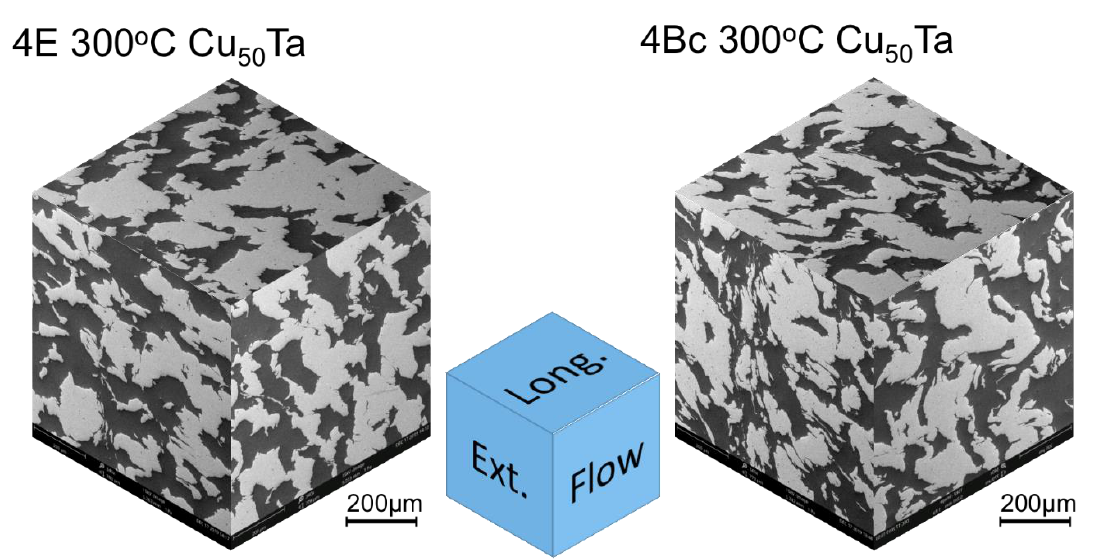
Figure 4. 3-D representation of microstructure along three different sectioning planes in Cu-Ta composites consolidated at 300 °C by routes 4E and 4Bc. Table 2. Summary of phase boundary trace length per unit area and % area of Cu phase for Cu-Ta composites processed at 300 °C.